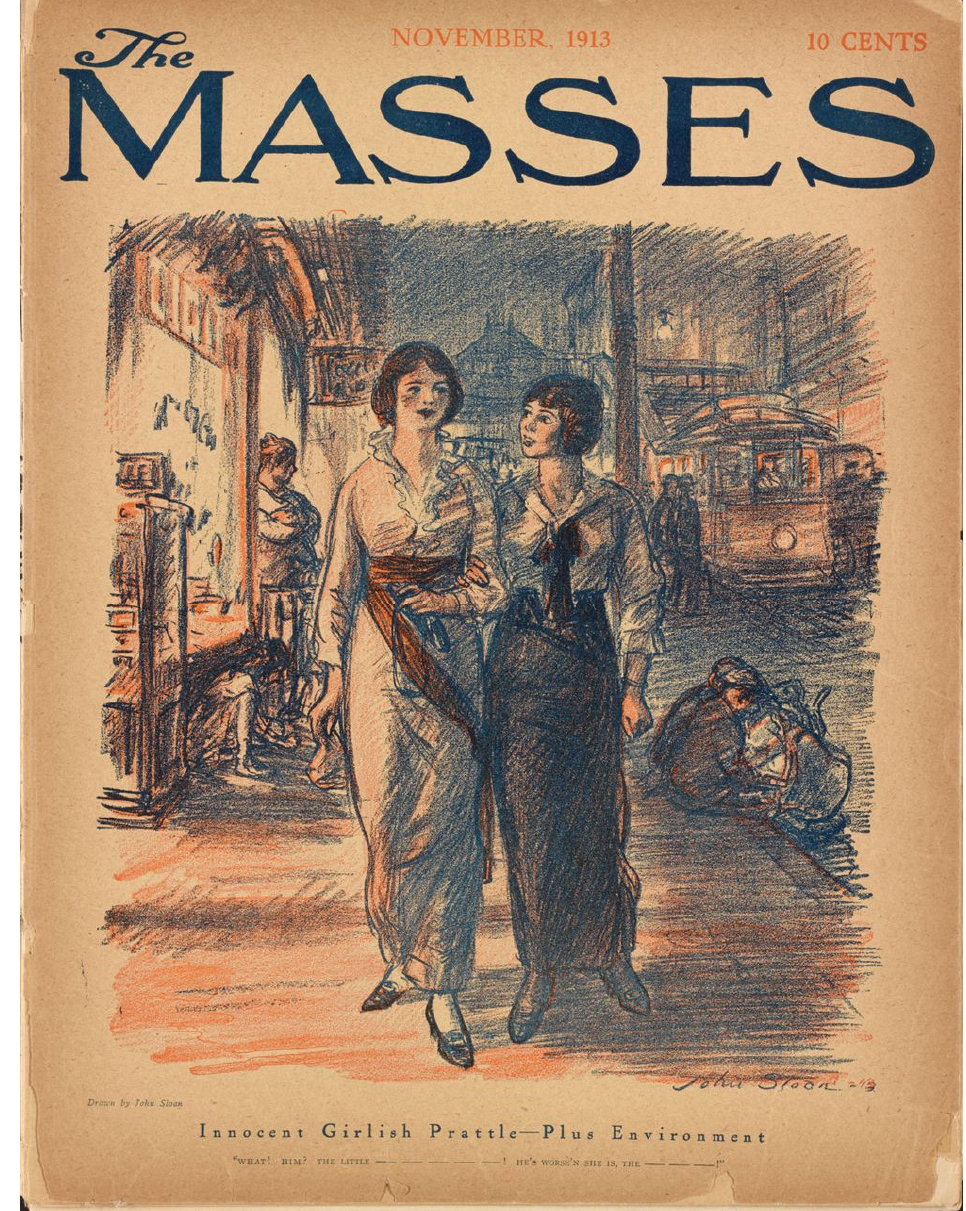
Figure 33. John Sloan. Cover image: Innocent Girlish Prattle—Plus Environment. The Masses V. 5. No. 2 (November 1913). The Modernist Journals Project. Available online: https://modjourn.org/issue/bdr527495/ (accessed on 29 August 2022).